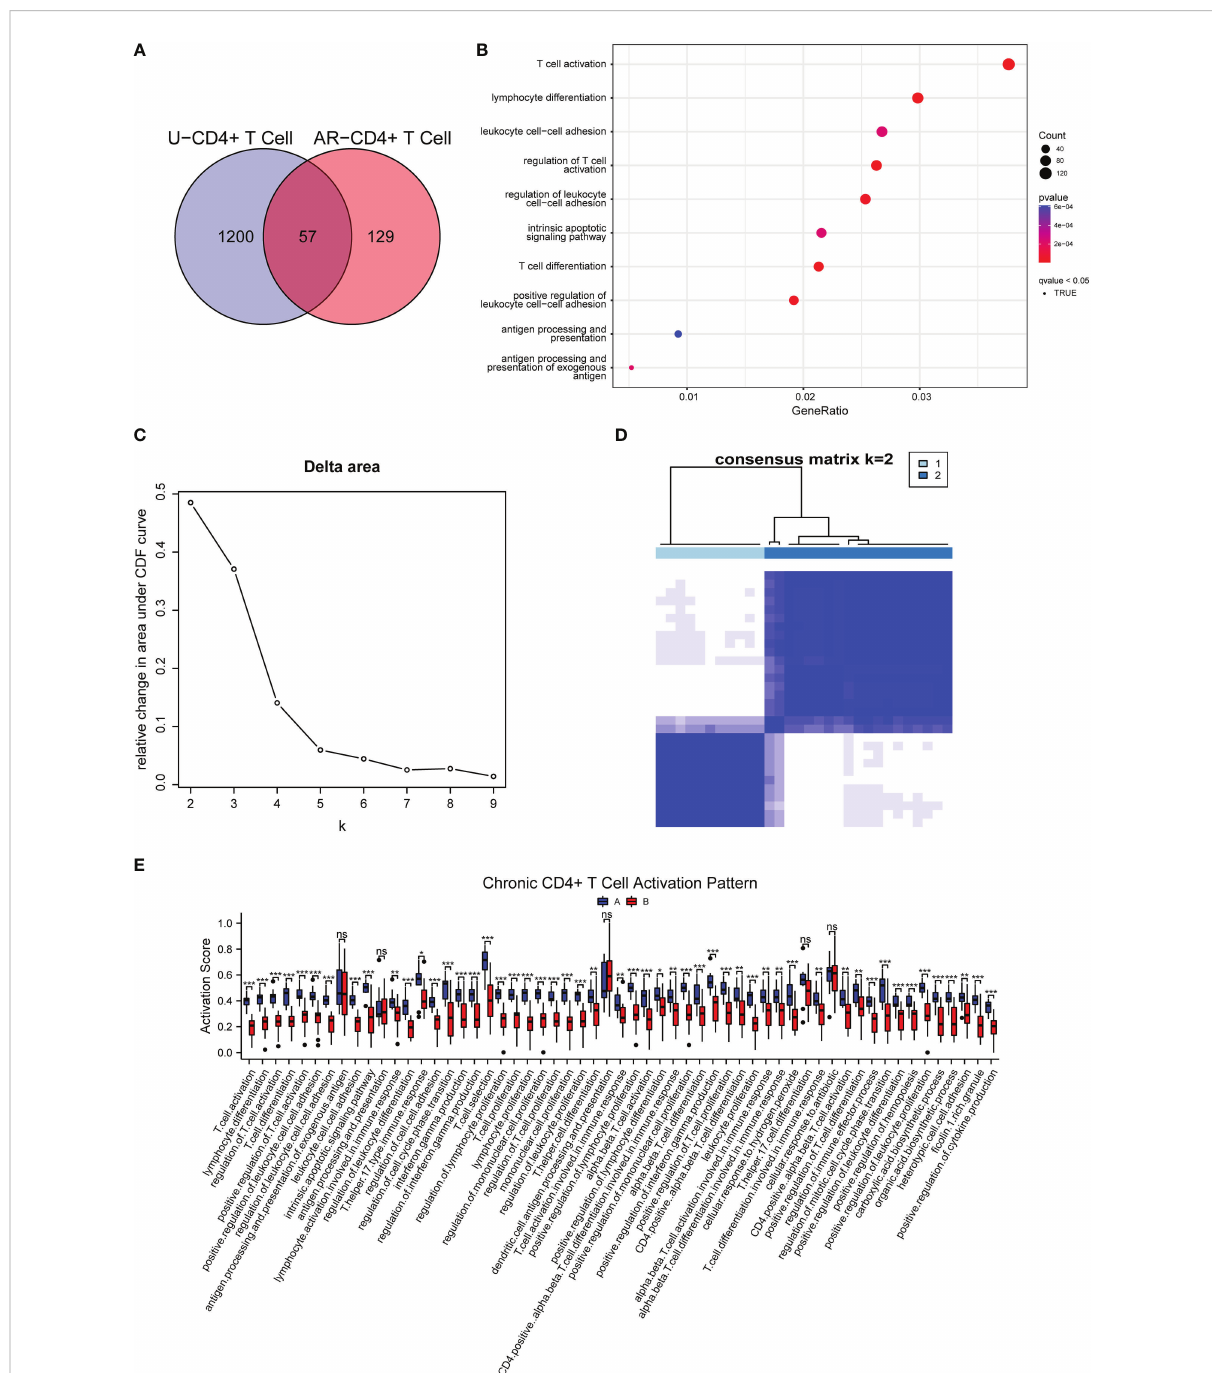
FIGURE 8 Categorization of AR and CSU co-regulated pathways and corresponding patterns of chronic CD4+ T cell activation. (A) Venn diagram exhibited the shared signaling pathways associated with CD4+ T cells in AR and CSU patients. (B) GSVA shown by bubble plots. (C) Relative change in area under the CDF curve under different values of (k) (D) The consensus matrix for k = 2. (E) Box plot showing differences of two types of chronic CD4+ T cell activation